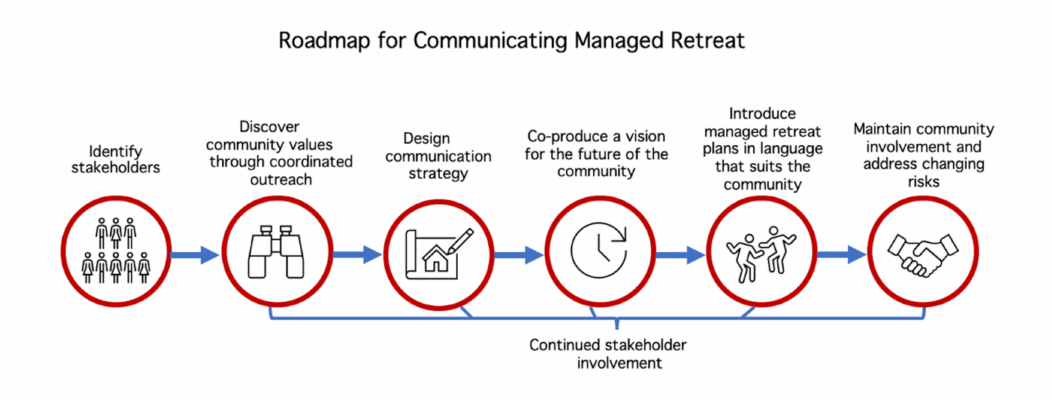
Figure 2. Roadmap for Communicating Managed